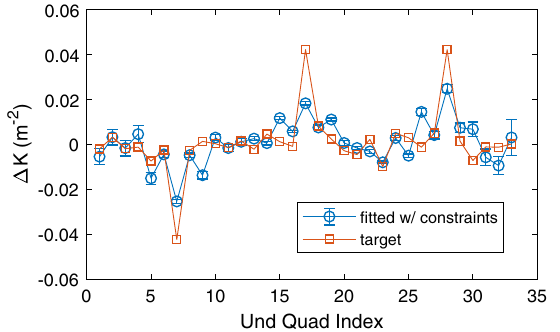
FIG. 21. Fitted quadrupole gradients using constrained fitting for the LCLS undulator section with the same simulated data as in Fig. 19. Correction of the lattice model with the fitted solutions reduces beta beat to below 2%. using constrained fitting. The average error sigma for the gradient parameters are 1 . 9 × 10 − 3 m − 2 , with the weight factors w ¼ 0 . 02 for all quadrupoles [see Eq. (11)]. Even though the fitted gradient values are significantly different from the target solution, the beta beats of the corrected lattices are below 2%.